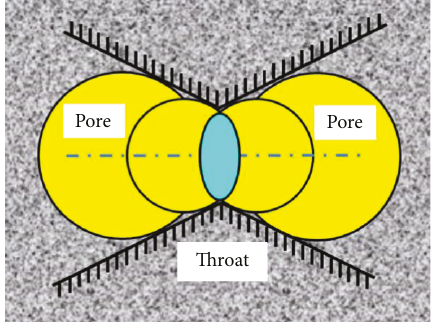
Figure 9: Pore and throat recognition